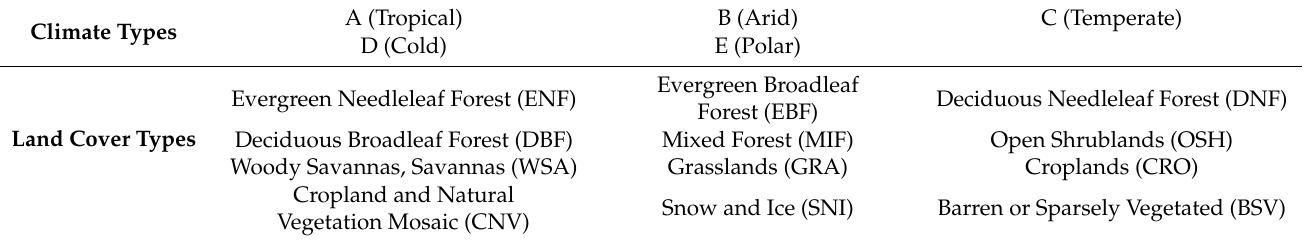
Table 1. Descriptions of the climate and plant types in this study are based on the Köppen-Geiger climate classifications and the MODIS IGBP land cover types, respectively. The details regarding the codes of Köppen-Geiger climate classifications are provided by Beck et al.